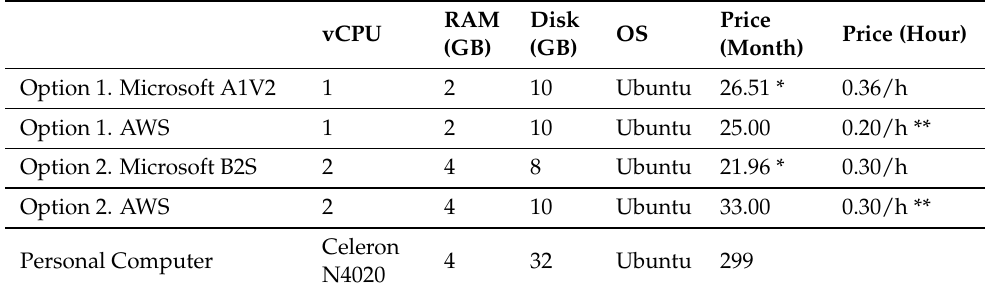
Table 8. Cost associated with a desktop